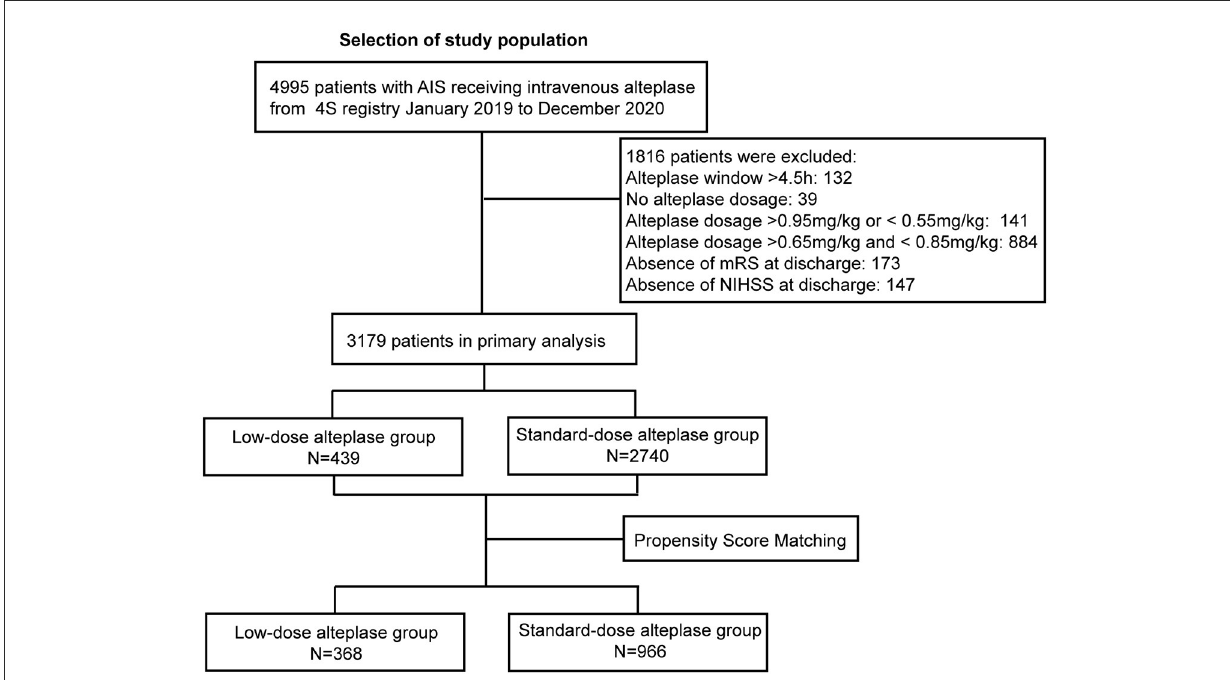
FIGURE1 Study flow chart and numbers of eligible patients in each group. 4S, Shanghai Stroke Service System; AIS, acute ischemic stroke; NIHSS, National Institutes of Health Stroke Scale [range, 0–42 (most severe)]; mRS, modified Rankin scale [range, 0–6 (most